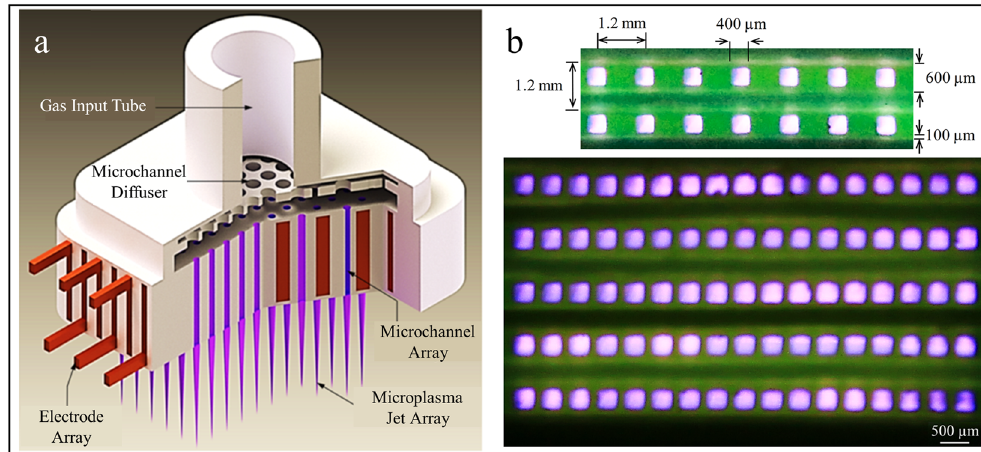
Fig. 1 Illustration of a microplasma jet array. a Cutaway view of the 3D-printed microplasma jet array device and illustration of the installed electrode arrays (in red) with the array in operation, producing multiple plasma jets (in purple). b End-on view of two arrays of microplasma jets operating under atmospheric pressure air. Scale bar represents 500